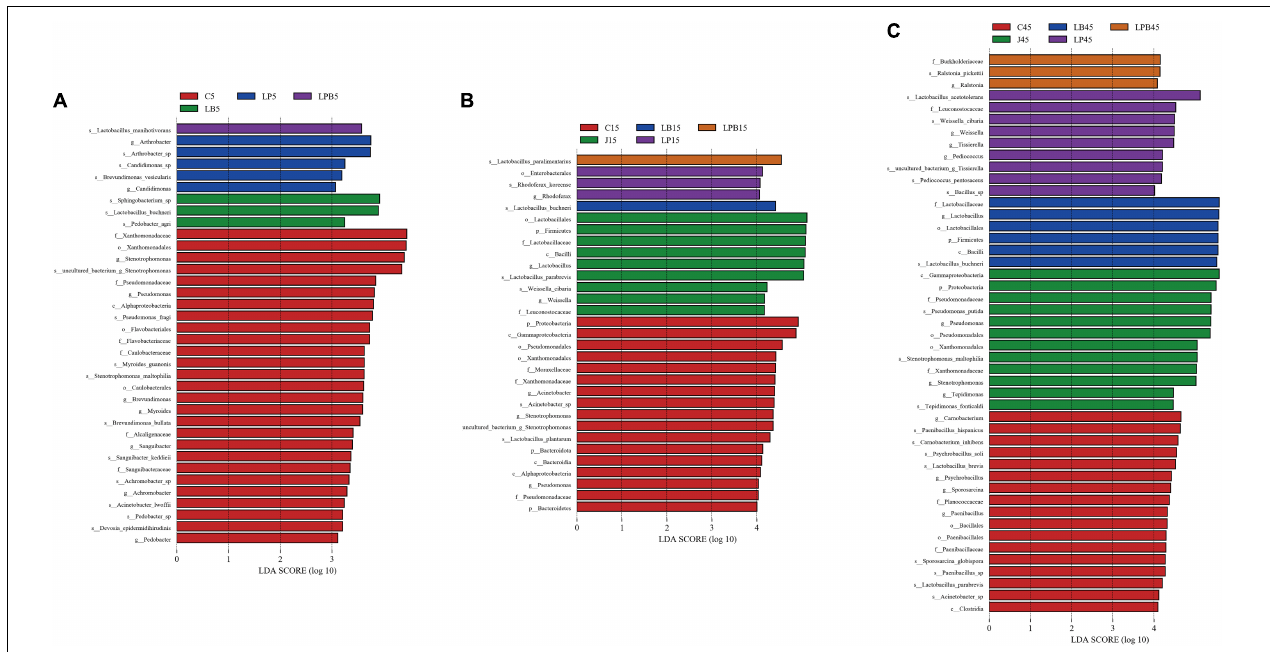
FIGURE 5 | Comparison of microbial variations during the ensiling using the Latent Dirichlet allocation effect size (LEfSe) analysis using the Kruskal-Wallis test ( P < 0.05) with linear discriminant analysis (LDA) score > 3.0. 5 days (A) , 15 days (B) , and 45 days (C) of ensiling. C, control; J, pre-fermented juice-treated silage; LP, L. plantarum -treated silage; LB, L. buchneri -treated silage; LPB, L. plantarum + L. buchneri- treated silage.